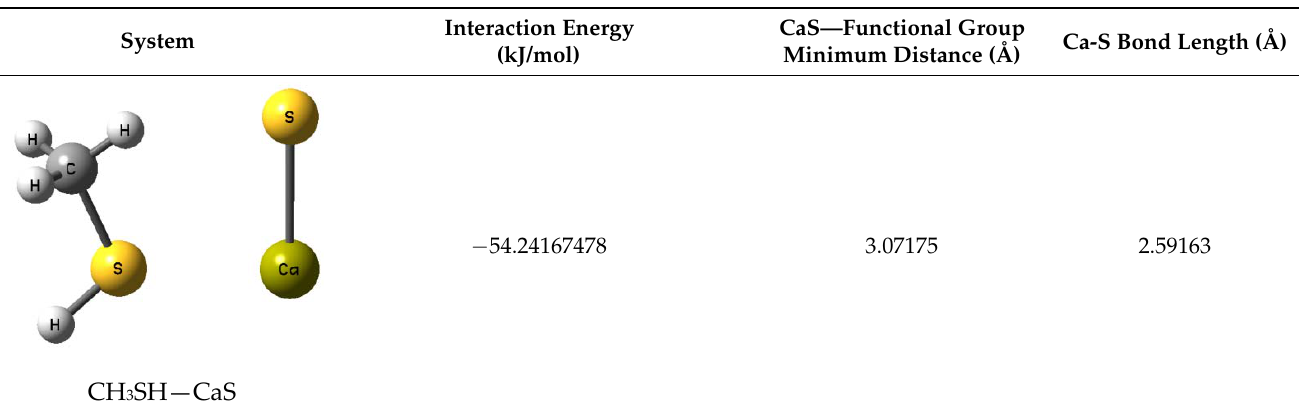
Figure 9. The upper panel summarizes the effect of CaS nanoclusters in the number of apoptotic and necrotic adenocarcinoma cells. The effect of these nanostructures in the number of apoptotic and necrotic normal fibroblasts is indicated in the lower panel. The (*) mark indicates statistically significant values. Table 2. Optimized structures and interaction energies of CaS with several functional groups of interest in a cell. The smallest distance between calcium sulfide and the functional group as well as the Ca-S bond length are also indicated in the table.